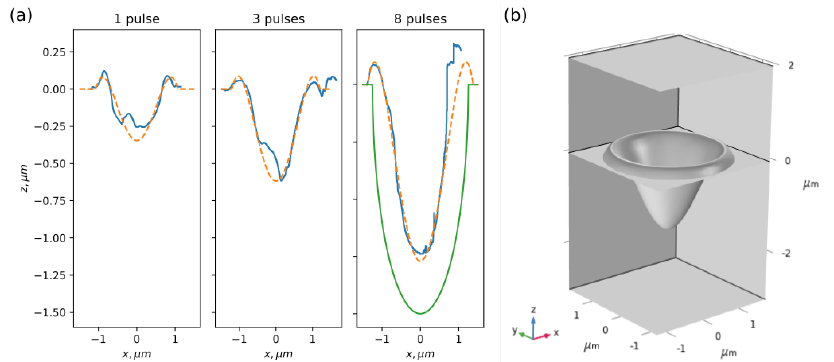
Figure 15. ( a ) AFM profiles of ARM craters inscribed with an energy of 37.5 nJ and a different number of pulses (solid) and 4th order approximations (dashed). Semi − ellipsoidal modification assumption for 8 pulses (green); ( b ) the model's geometry: upper layer − air, lower layer − GaSe. Simulation results are shown at Figure 16. They qualitatively corresponded to ex- perimental data, depending on the number of pulses: transmittance rapidly decreased in the shortwave region and increased in the longwave region. However, transmittance for wavelengths above 7 µm was higher in the experiment than in the simulation for the corresponding number of pulses. Geometry of ablation craters did not fully define the optical property of the structure. More likely, laser pulse impacts additionally caused change to the refractive index on the crystal surface due to changes of chemical compo- sition, for example, the formation of a thin Ga 2 O 3 layer [16], which has a refractive index of about 1.88 [25], leading to an increase in transmittance. Better agreement of simulation and experiment in the long-wave region shown in Figure 17 was obtained with the modification profile in the form of a semi-ellipsoid (diameter 2.5 µm, depth 2 µm). The ablated volume in this case was bigger than that ob- tained with AFM, which could prove the existence of a domain a with lower refractive index.